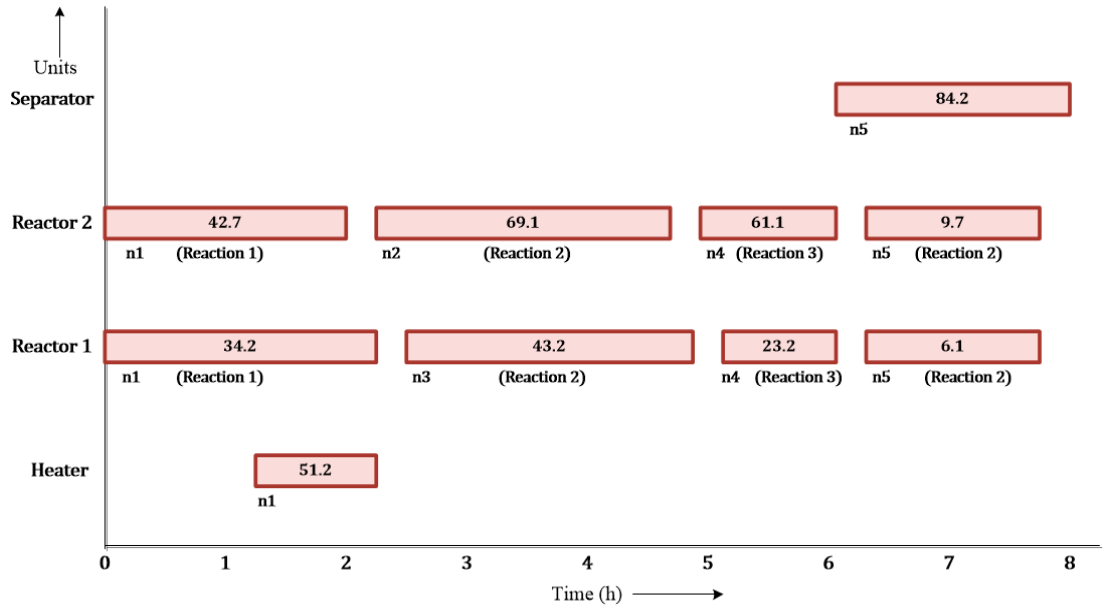
Figure 5. Production schedule obtained for the sequential approach.